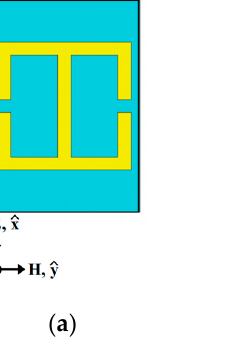
Figure 4. Schematic diagram of the perfect absorber for terahertz band designed by Tao et al. [39] ( a ) Electric resonator on the top of a polyimide spacer; ( b ) cut wire on GaAs wafer; ( c ) single unit cell showing the direction of propagation of incident EM wave.